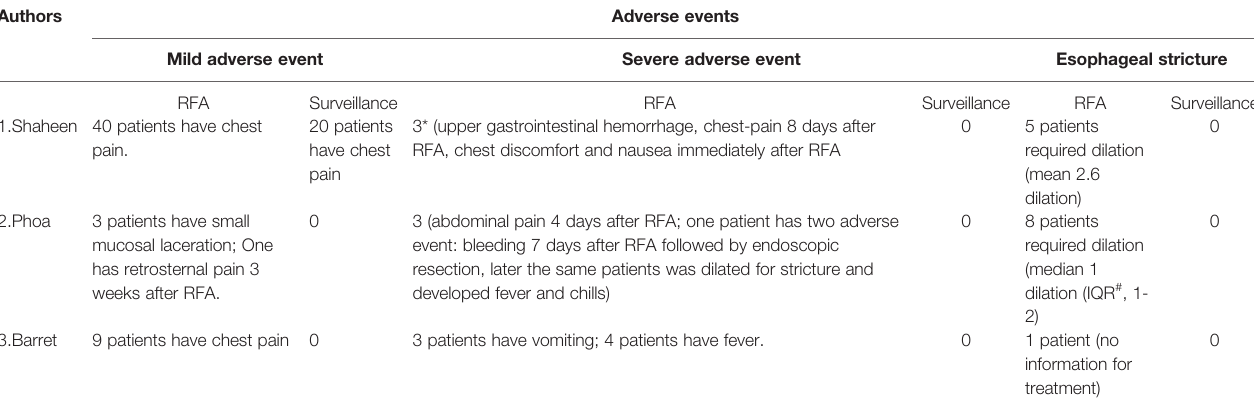
TABLE 3 | The information of adverse event.